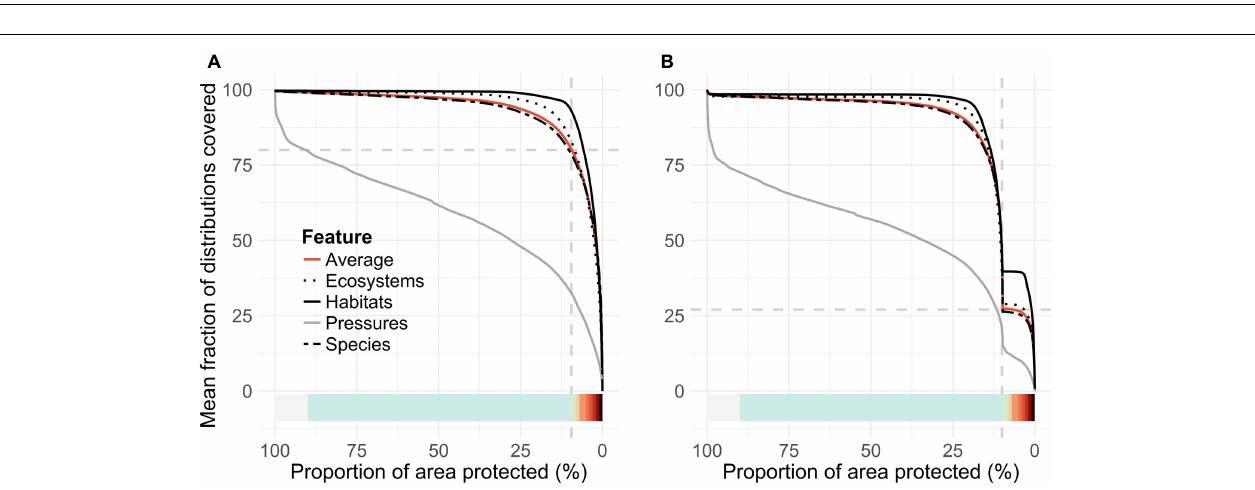
FIGURE 4 | Zonation priority rank maps across the Finnish seascape. (A) Unconstrained priority rank map, which corresponds to the establishment of a completely new MPA network. (B) A constrained, hierarchical priority rank map, where the highest priorities are forced inside the present MPA network.